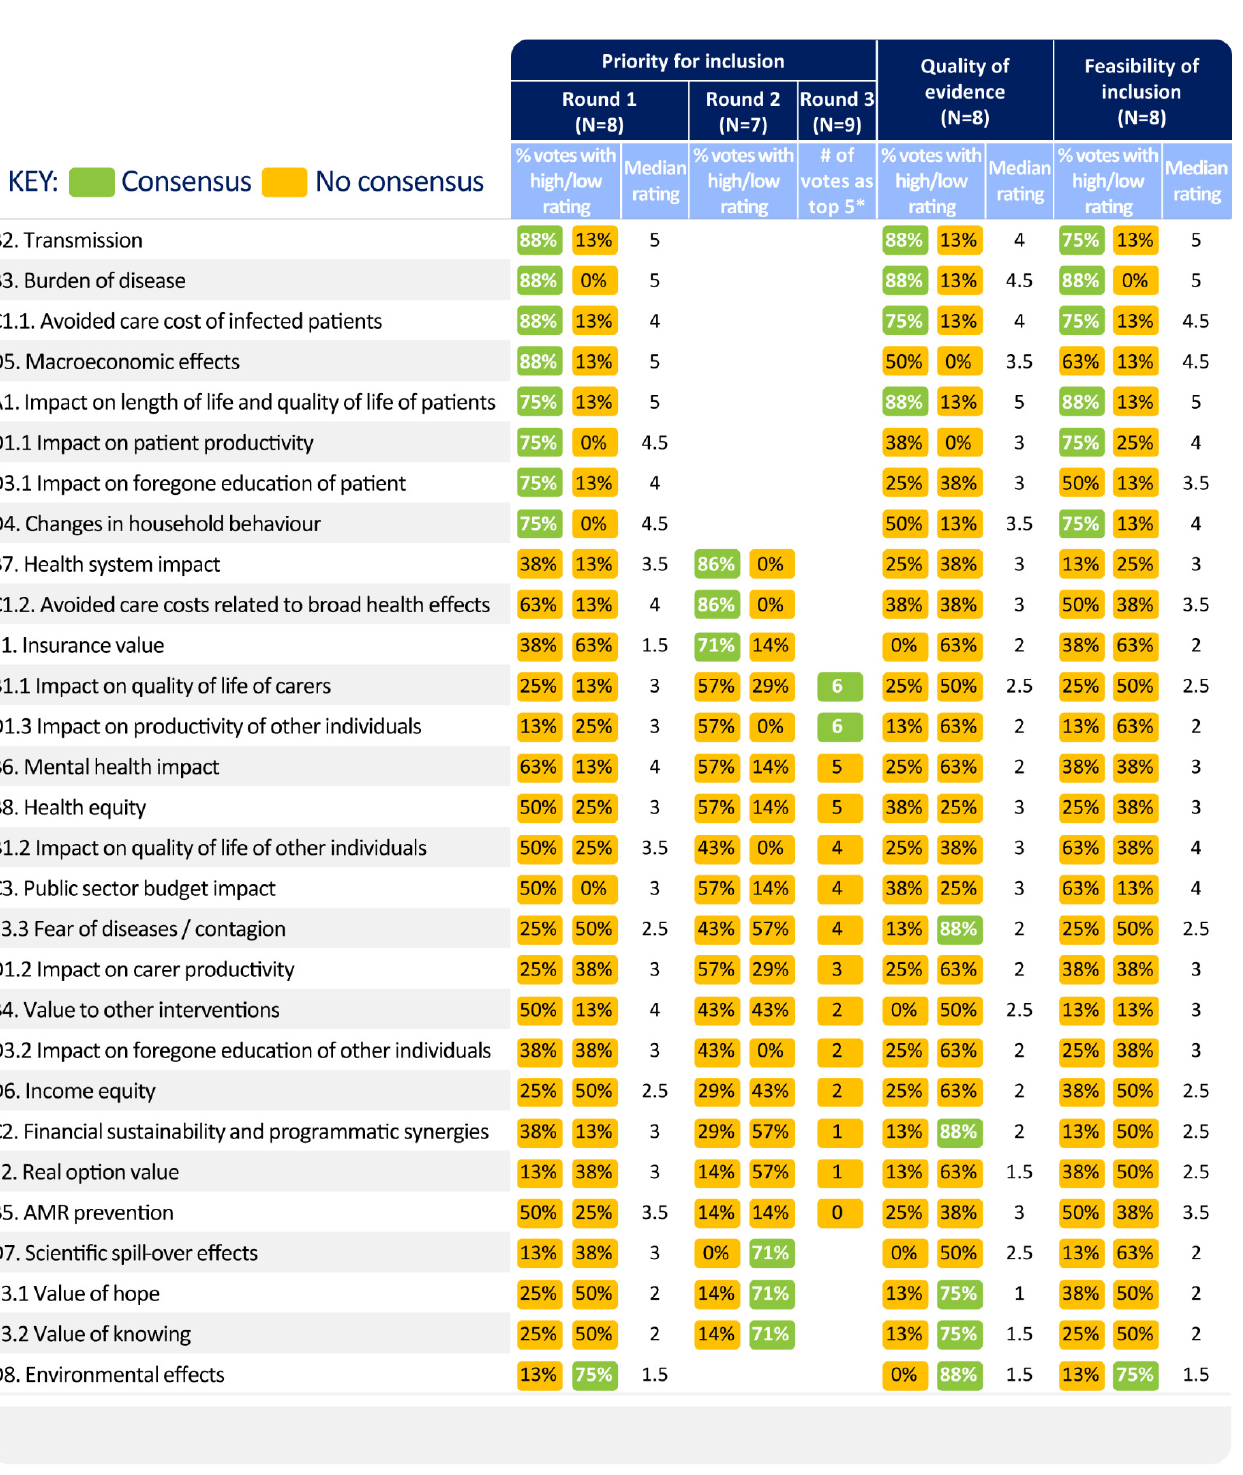
Figure 4. Results of expert elicitation rounds. * Experts were asked to choose the top five elements among the ones lacking consensus in Rounds 1 and 2. High rating: 4 or 5 on a 5-point Likert scale. Low rating: 1 or 2 on a 5-point Likert scale. Consensus in Round 1 was defined as >75% (six out of eight) of participants providing either a high rating (4 or 5) or a low rating (1 to 2) for a value element. In Round 2, consensus was defined similarly, using ≥ 67% (six out of nine) as threshold. Note—Vaccine anxiety was added to the framework as a result of expert panel discussions and is not covered in this table.